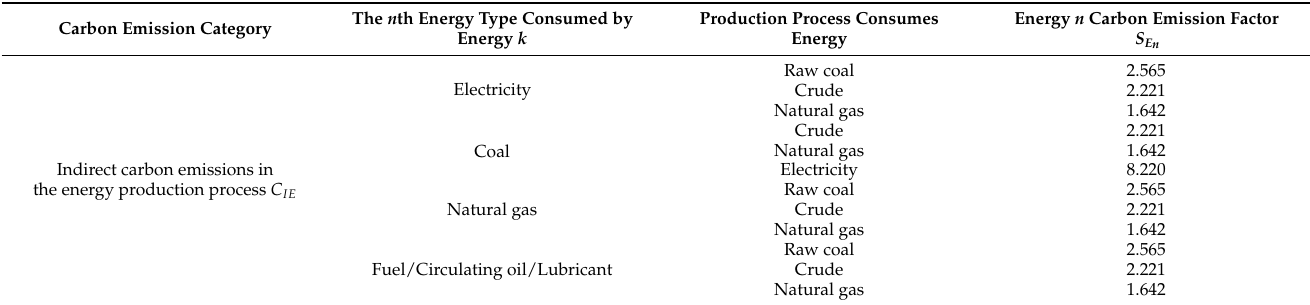
Table 5. Indirect carbon emission factors in energy preparation